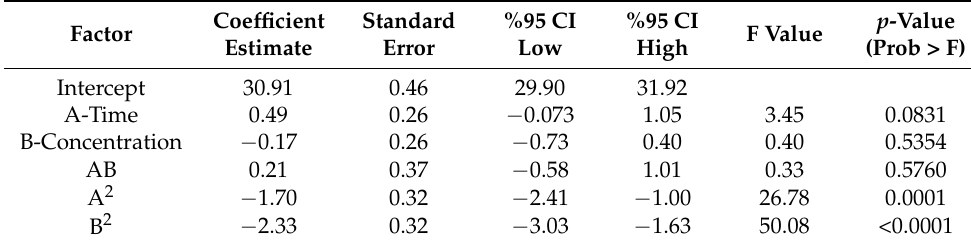
Table 3. The least-squares fit and coefficient estimate. Factor